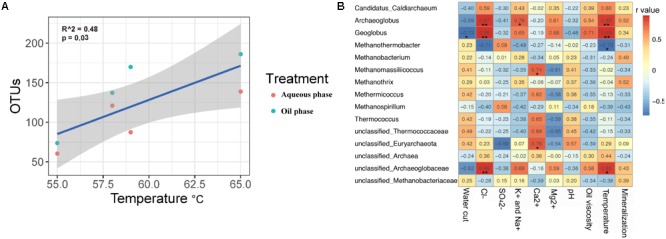
Pearson correlation analysis of environmental factors. (A) The linear correlation between observed OTUs and temperate (R2 = 0.48, p = 0.03). Observed OTUs were rarefied at the same sequencing depth (3300 reads). Blue and orange points represent samples from oil phase and aqueous phase, respectively. (B) The correlation between environmental variables and archaeal taxa (at genus level). Taxa with relative abundance <0.01% were eliminated. Data with one asterisk means p < 0.05, with two asterisk means p < 0.01. Color with red shows positive correlation while blue shows negative correlation. The bigger r-value shows the more correlative they are.